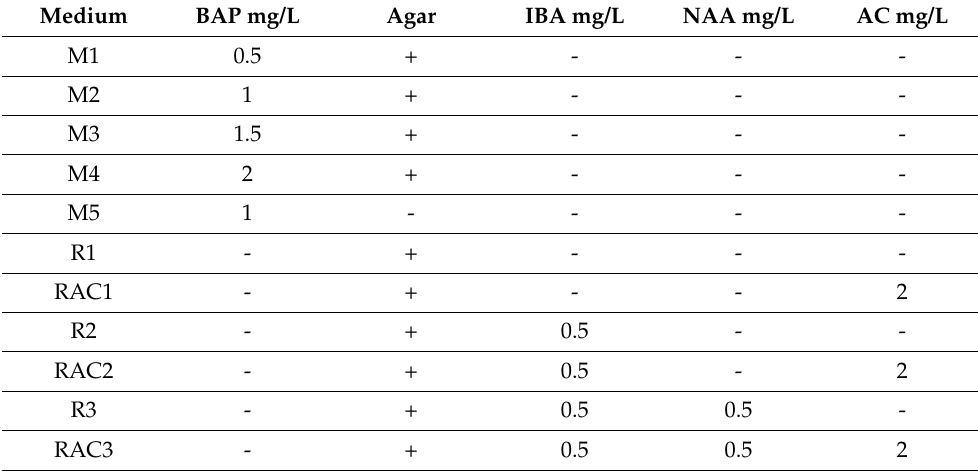
Table 3. Media used in the agar and temporary immersion bioreactor